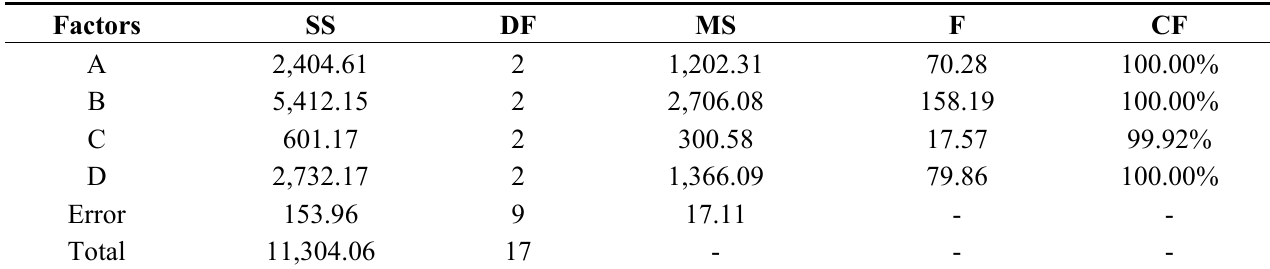
Table 4. Analysis of variance summary table of fatty acid methyl ester (FAME)